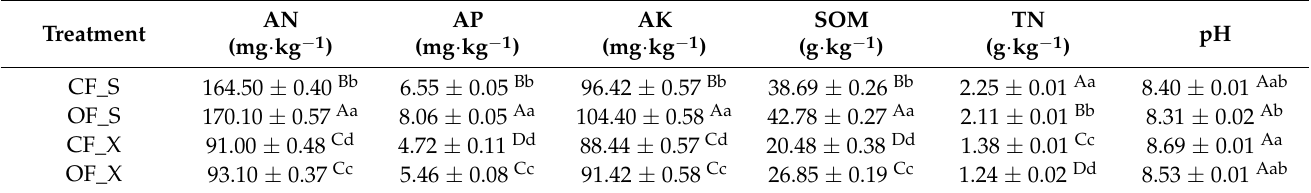
Table 1. Effects of cultivation patterns on soil physicochemical properties in different soil layers.